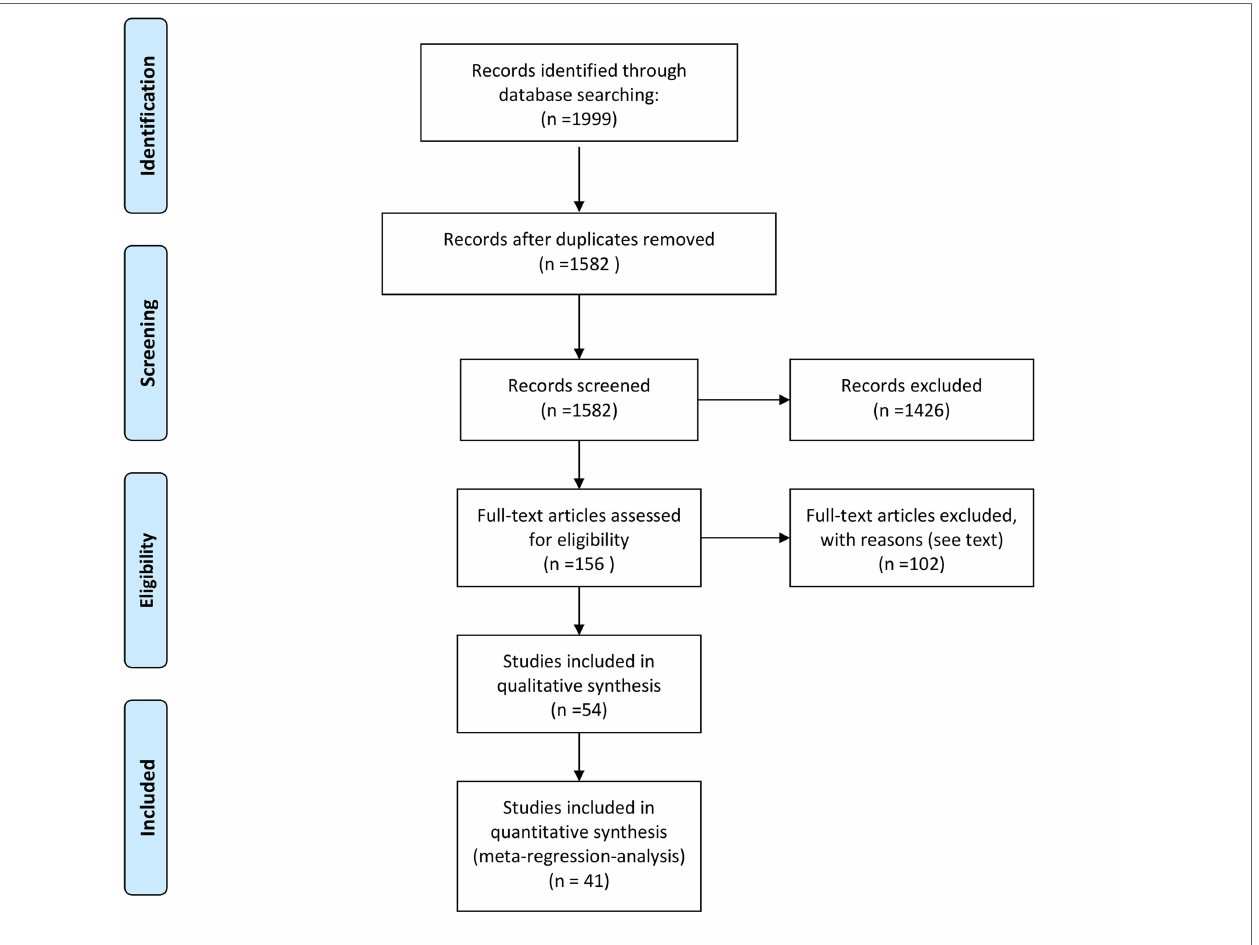
FiGURe 1 | PRiSMA flowchart